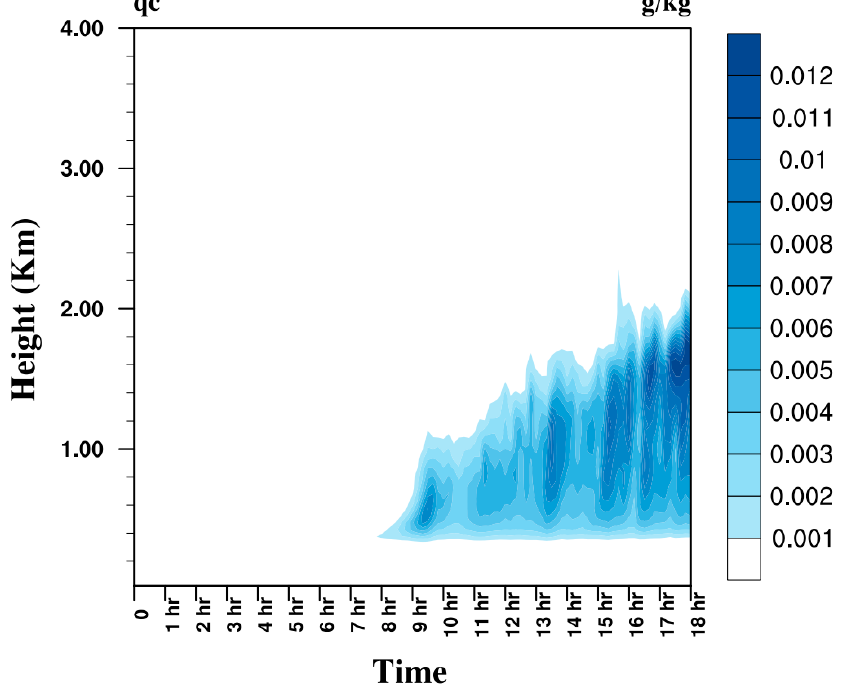
results are shown in Figure 4. The profiles were an average of the last two hours of the simulation when the clouds reached their steady height. The vertical velocity variance and the turbulence kinetic energy (TKE) are measures of the turbulence intensity, and the fluxes were determined by the covariance of the temperature and the moisture. Reynolds averaging was performed over the vertical velocity wind component to obtain the mean and turbulence parts in order to calculate the vertical velocity variance as shown below [20].